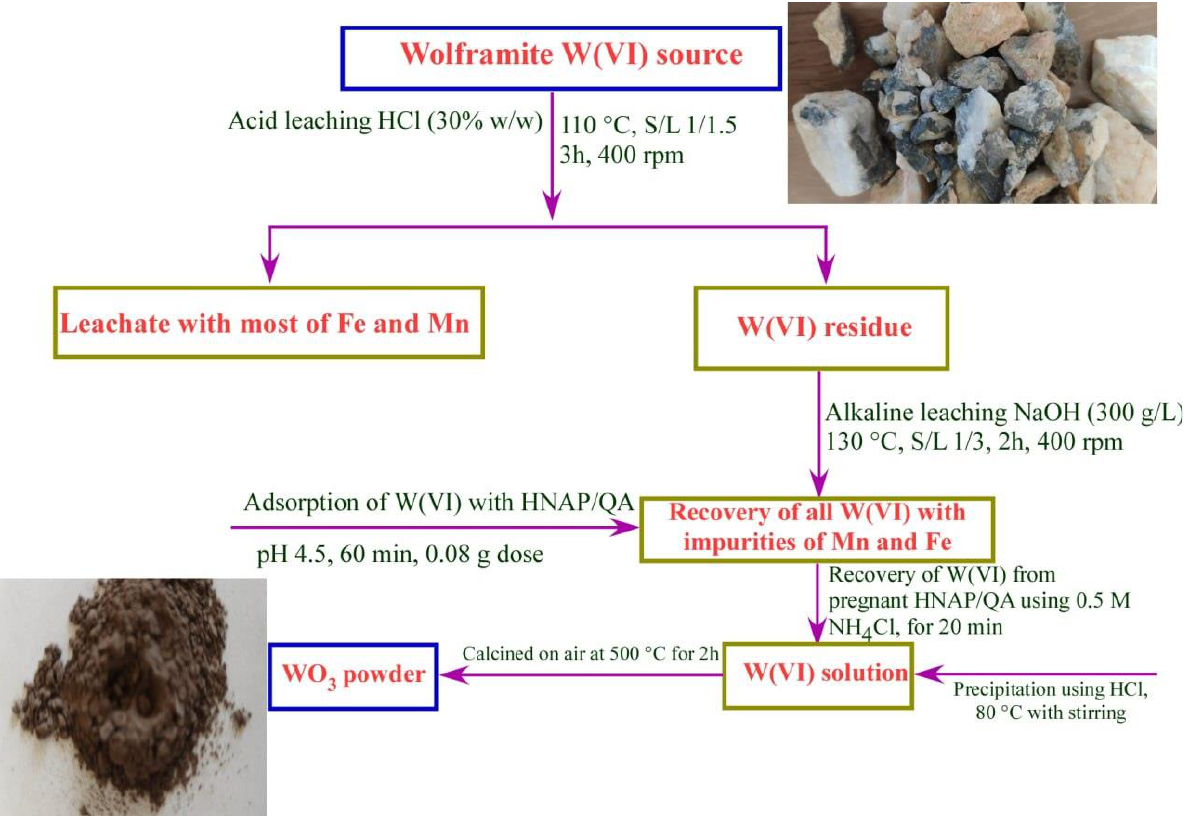
Figure 21. Flow sheet of the recovery of tungsten oxide from wolframite sample.